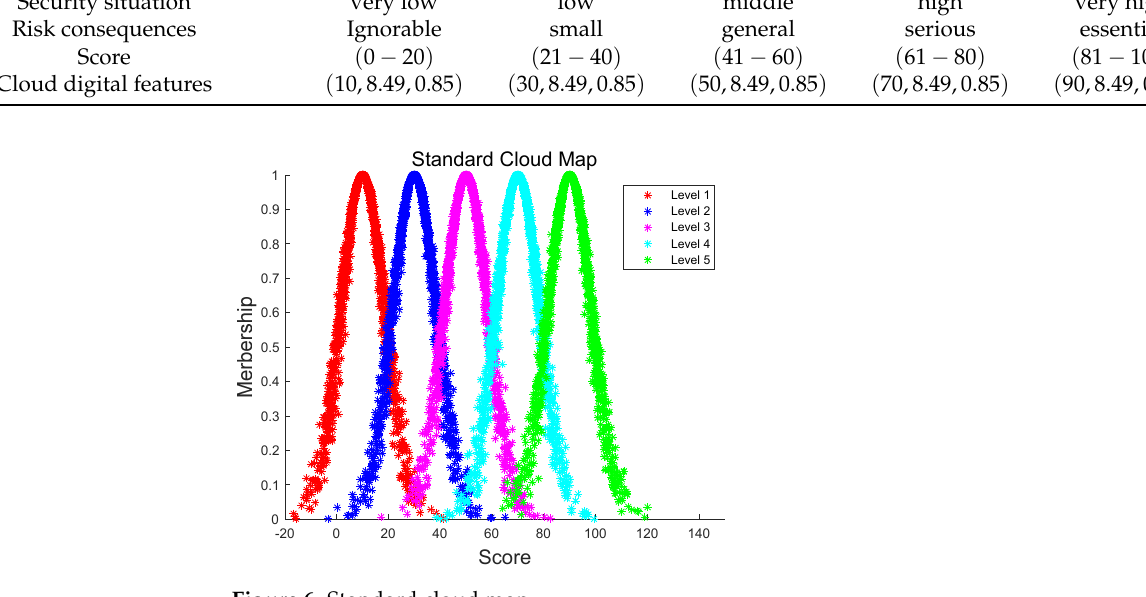
Figure 6. Standard cloud map.